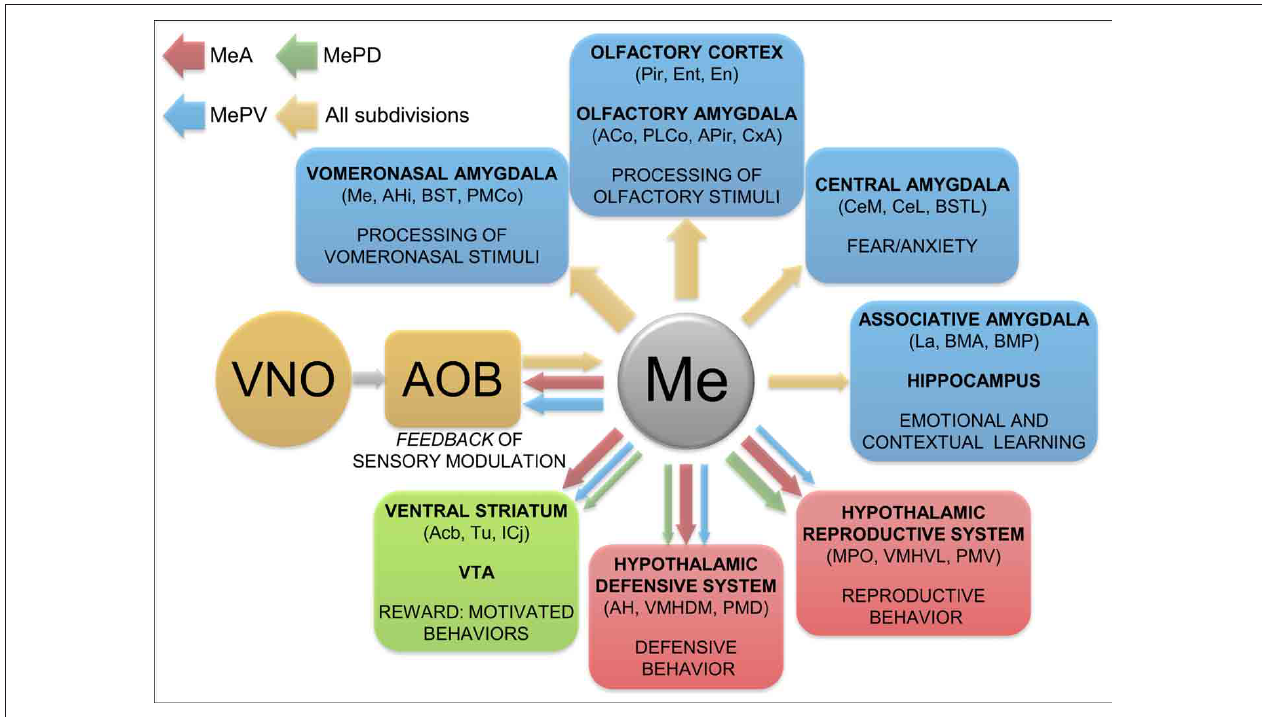
FIGURE 9 | Summary andfunctionalinterpretationoftheefferent projectionsarisenfromthe medialamygdaloidnucleus. Schematic representationofthemainefferentprojectionsofthemedialamygdaloidnucleus,